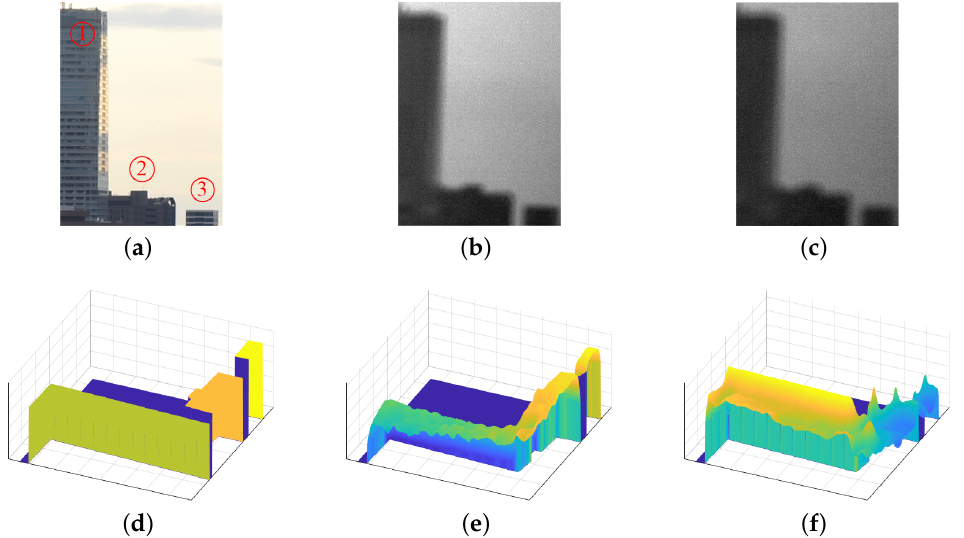
Figure 10. Estimated distance of scene 3 using a bispectral light extinction in bad weather. ( a ) RGB image. ( b ) Image at 905 nm. ( c ) Image at 980 nm. ( d ) Groundtruth. ( e ) Our result. ( f ) Result of comparison method.